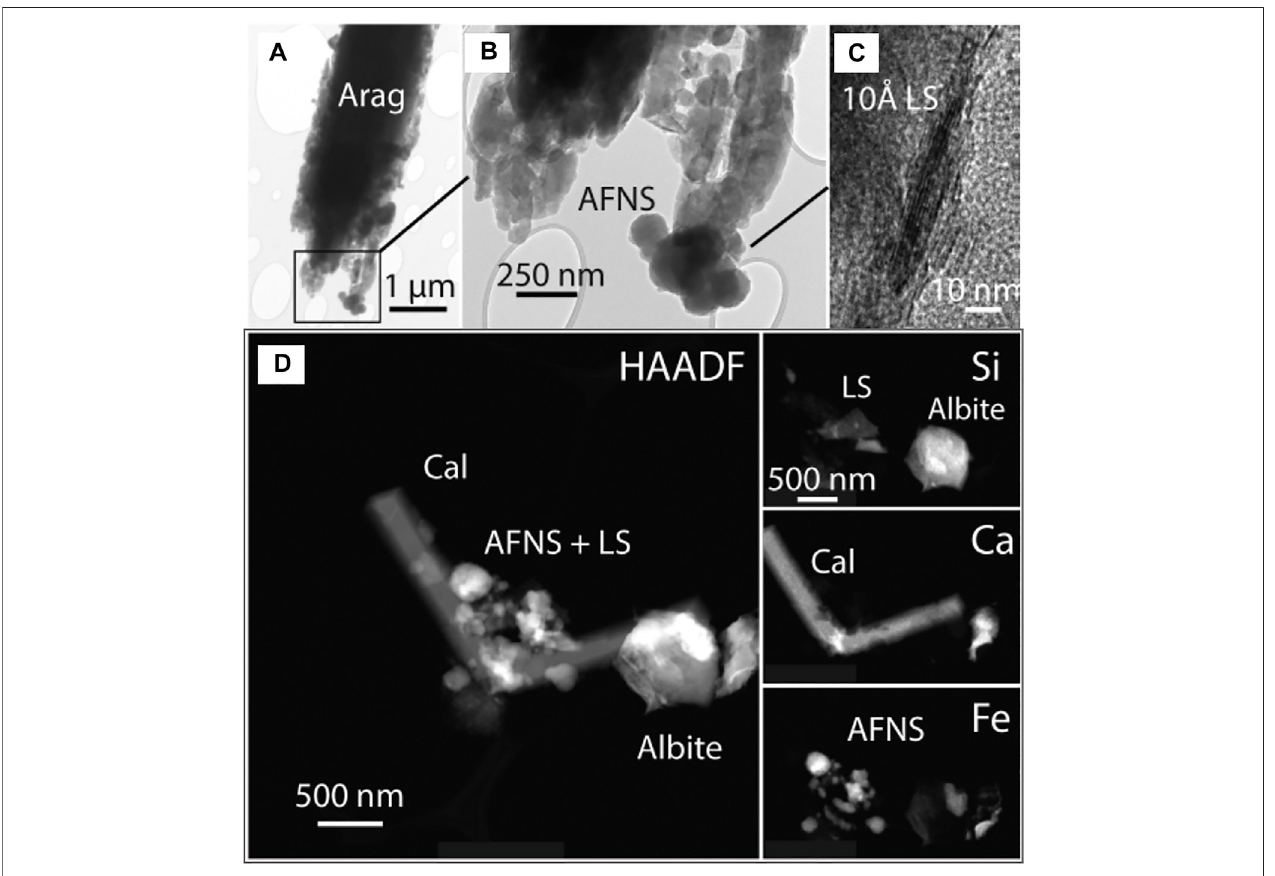
FIGURE 9 | TEM Results for ES26. (A) Aragonite laths constructed from nanoaragonite in what may be an oriented attachment growth process. SAED pattern show twin orientations is given in Supplementary Figure S22 . (B) Higher magni fi cation image of lath tip containing amorphous Fe-rich nanospheres (AFNS) and nanoaragonite. (C) HRTEM lattice image of nano-sized layered silicate (LS) on the perimeter of AFNS. EDX analyses indicate that the LS is also Fe-rich. (D) Collection of phases in ES26 examined by high-angle annular dark- fi eld (HAADF) imaging and Si K α , Ca K α , and Fe K α X-ray